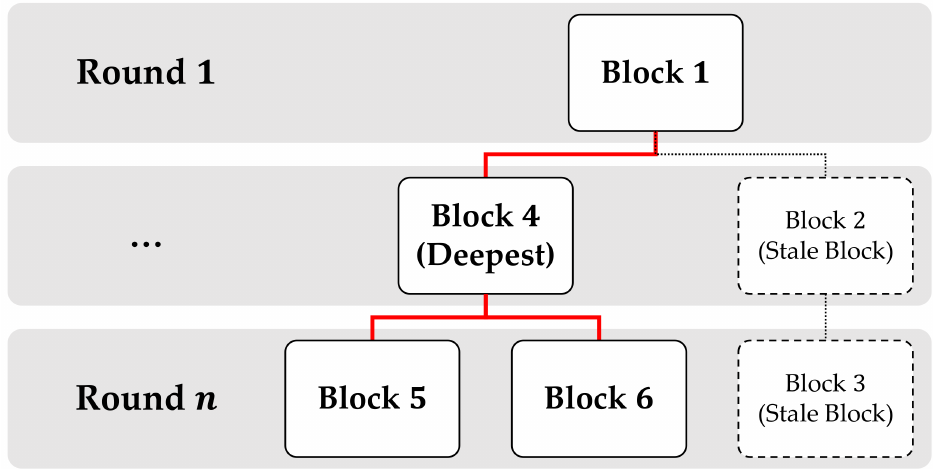
Figure 3. Proactive Approach for Selfish Mining Attacks.